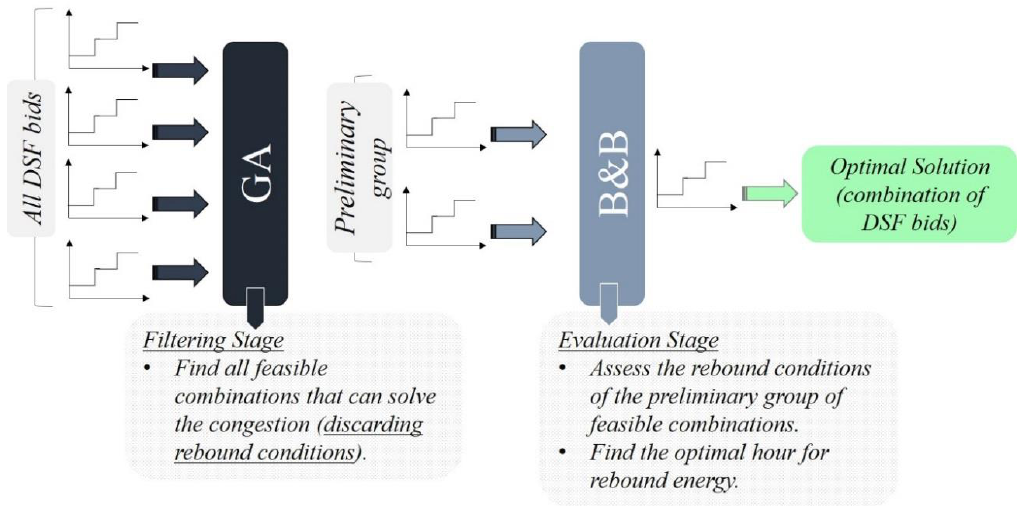
Figure 2. Optimization methodology flowchart.